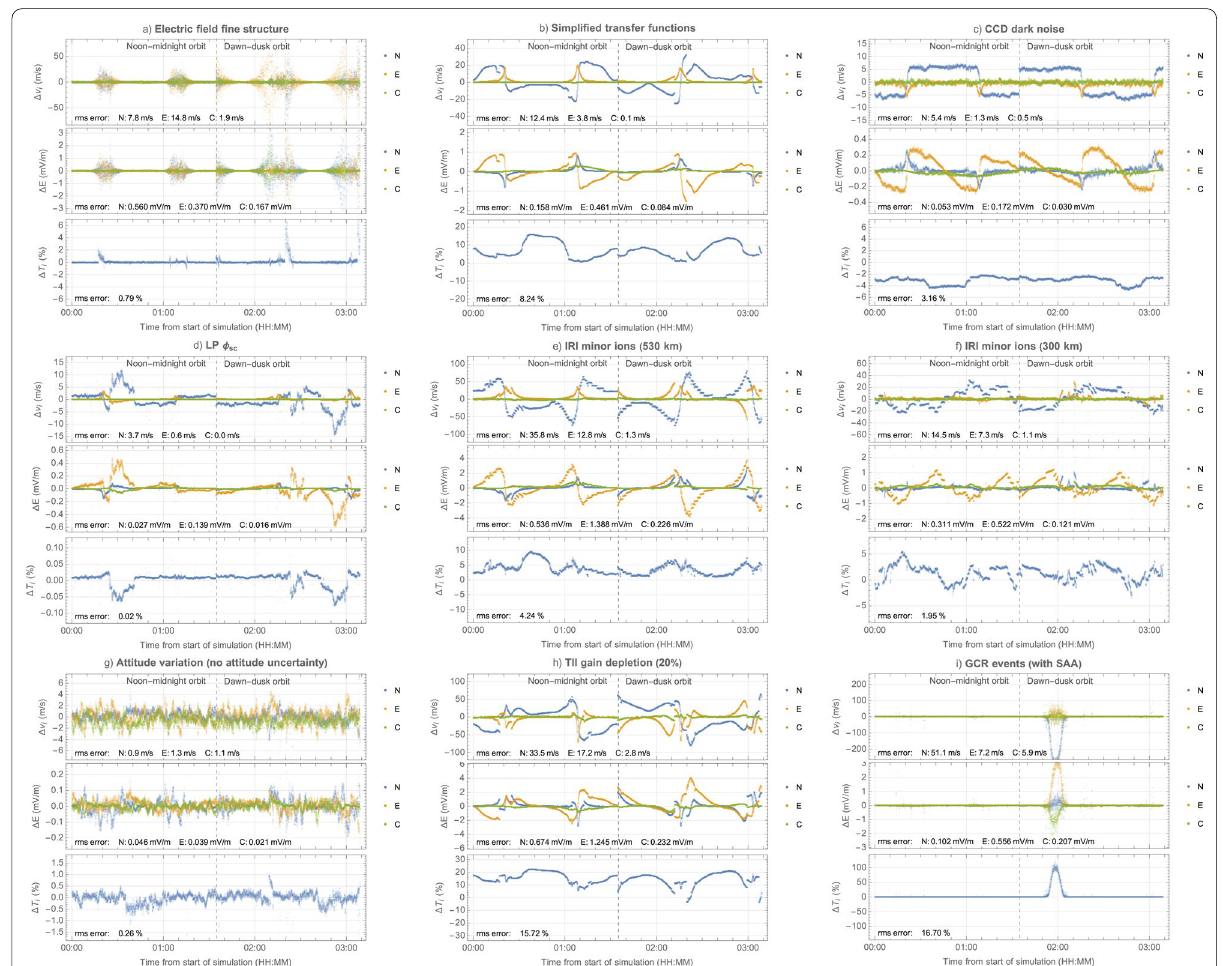
Fig. 27 Time series for systematic error sources estimated using the EES. Plotted in the same format as Fig.